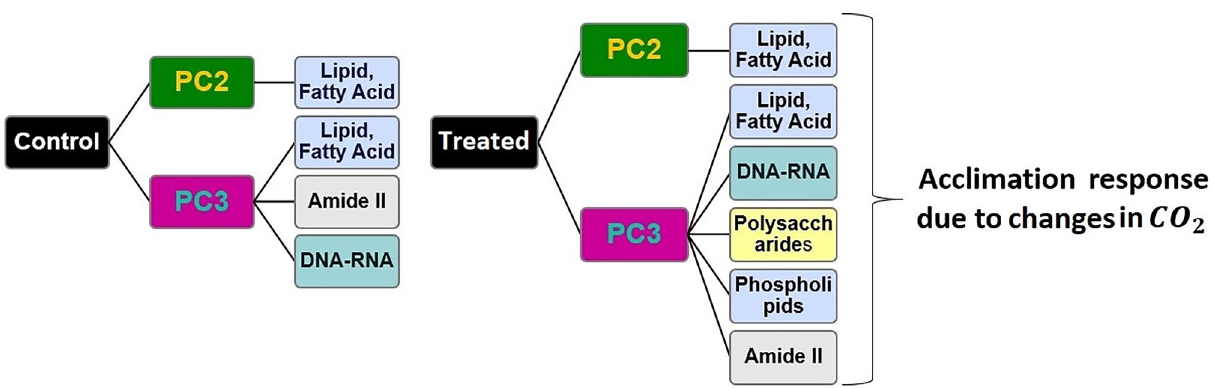
Figure 4. Dominant macromolecular changes. Chemically distinct molecules observed in each principal component (PC). The first variance is considered as PC2, and the second variance is